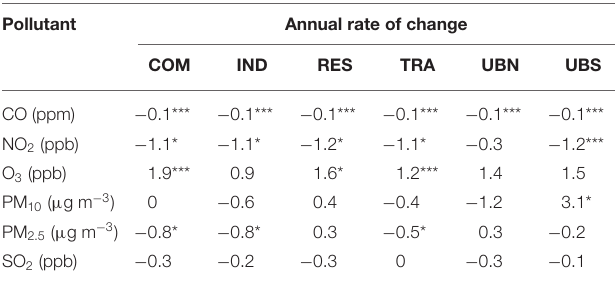
TABLE 2 | Trends for criteria air pollutants expressed in units of concentration during 2016–2020 at the selected monitoring sites within the MCMA. Pollutant Annual rate of